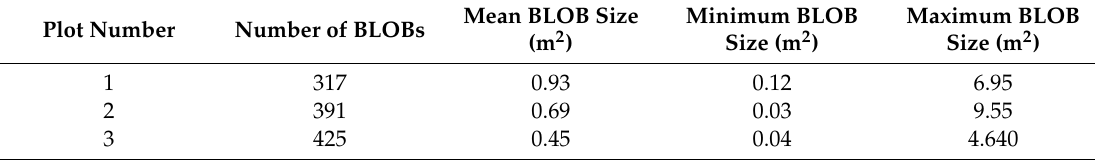
Table 2. Summary statistics of binary large objects (BLOBs) for three